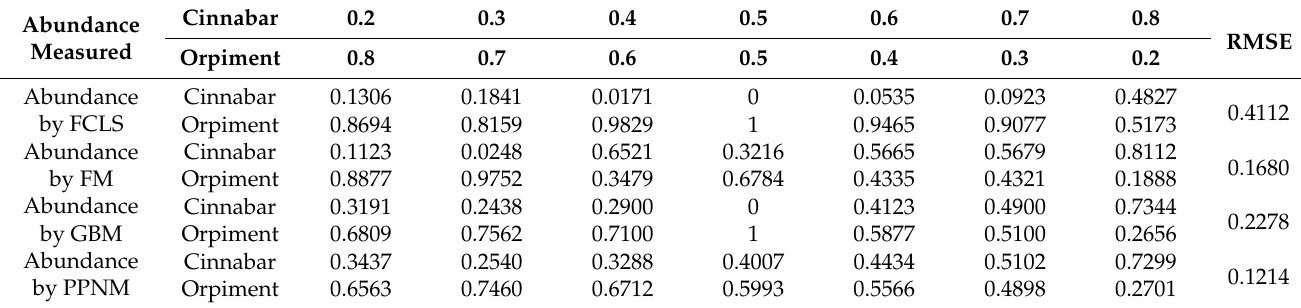
Table 5. Abundance estimated by different approaches for mixed pigment samples of cinnabar and